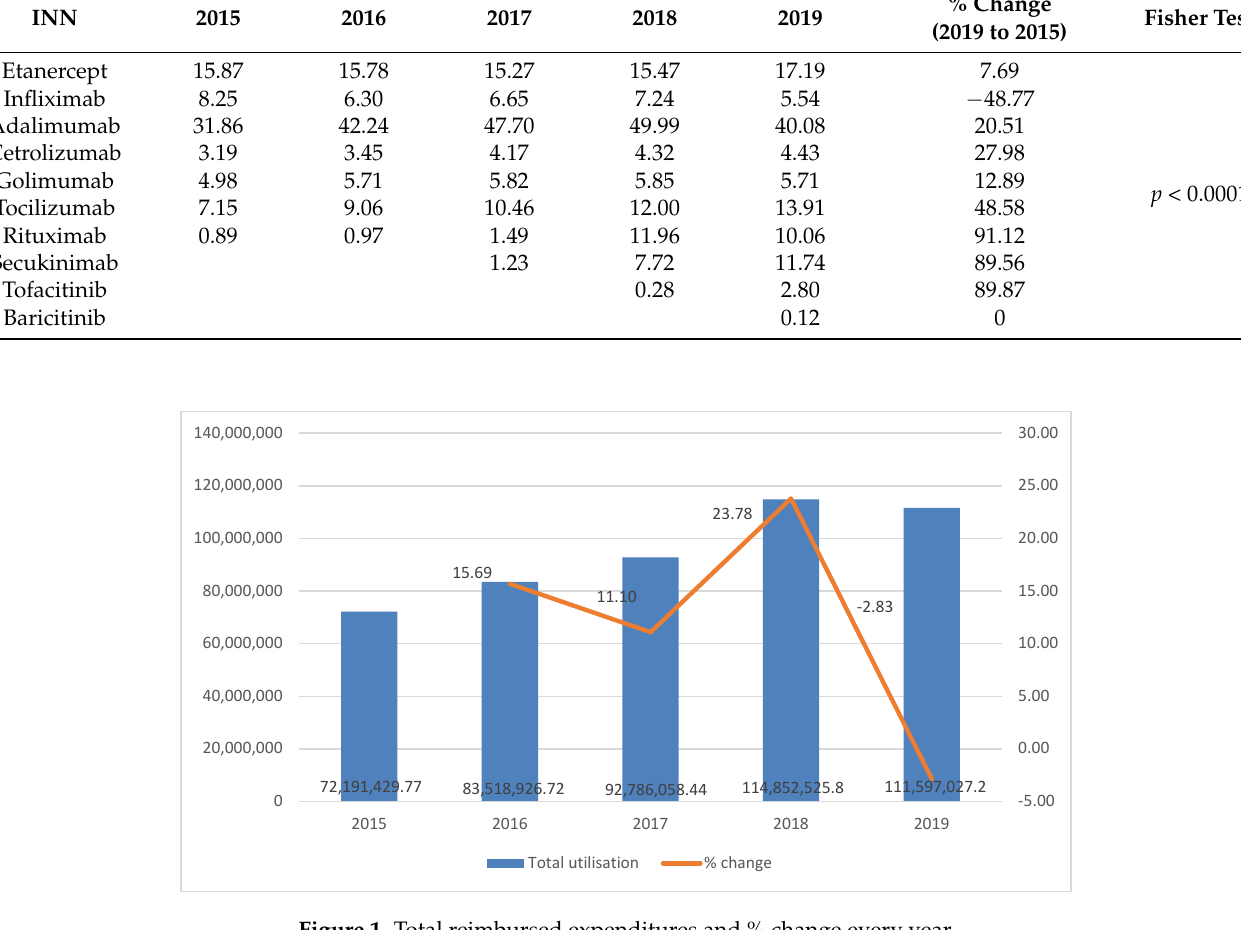
Figure 1. Total reimbursed expenditures and % change every year.